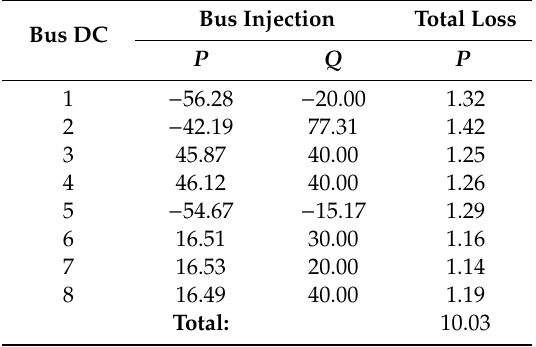
Table A52. Results of the mixed AC / DC PF calculations in Case 7-6. DC bus data.